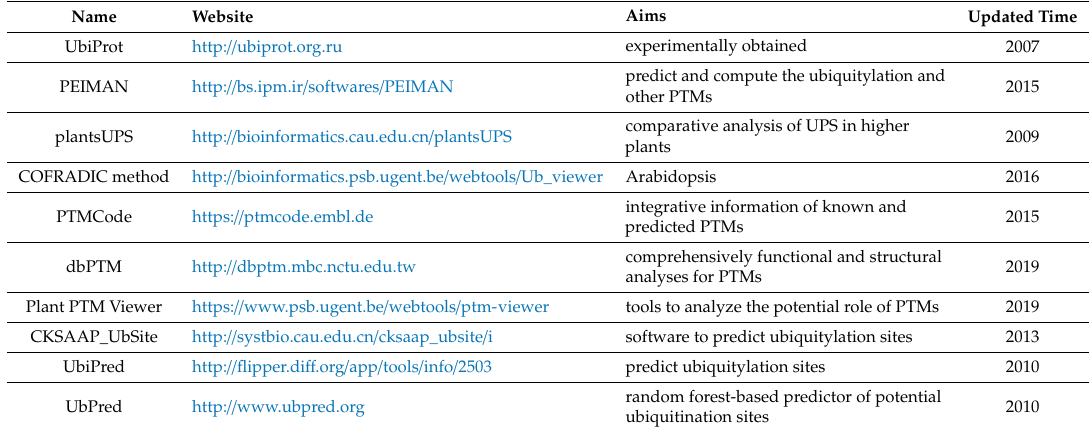
Table 2. Databases Developed for Plant